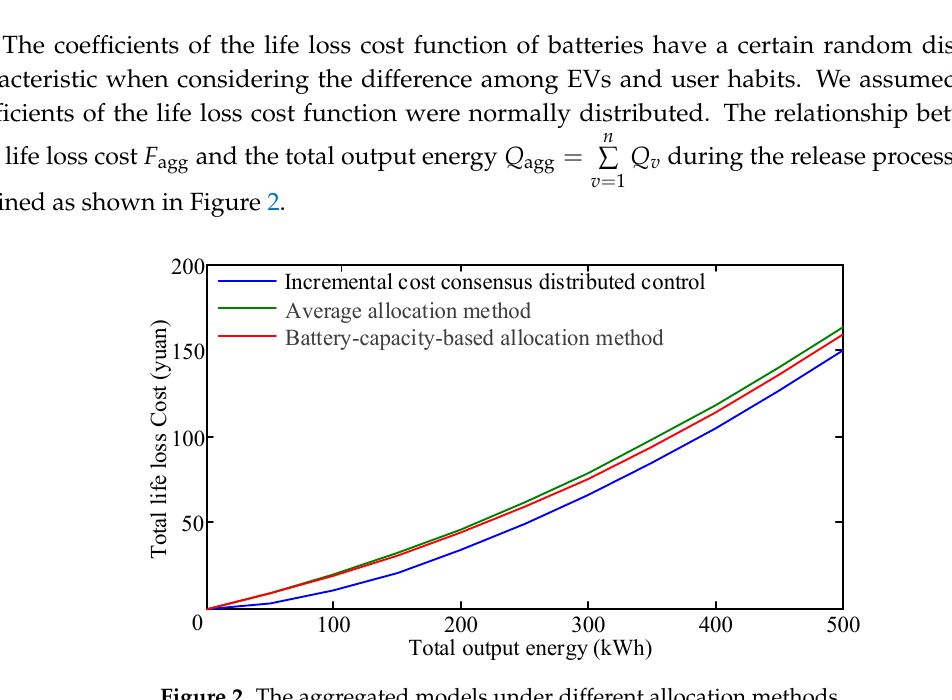
Figure 2. The aggregated models under different allocation methods.